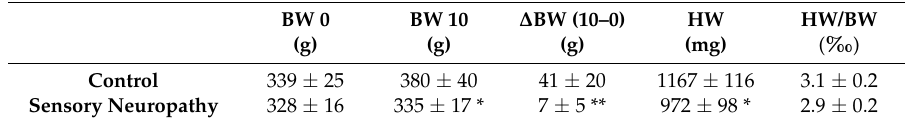
Table 1. Effect of sensory neuropathy on body and heart weights.